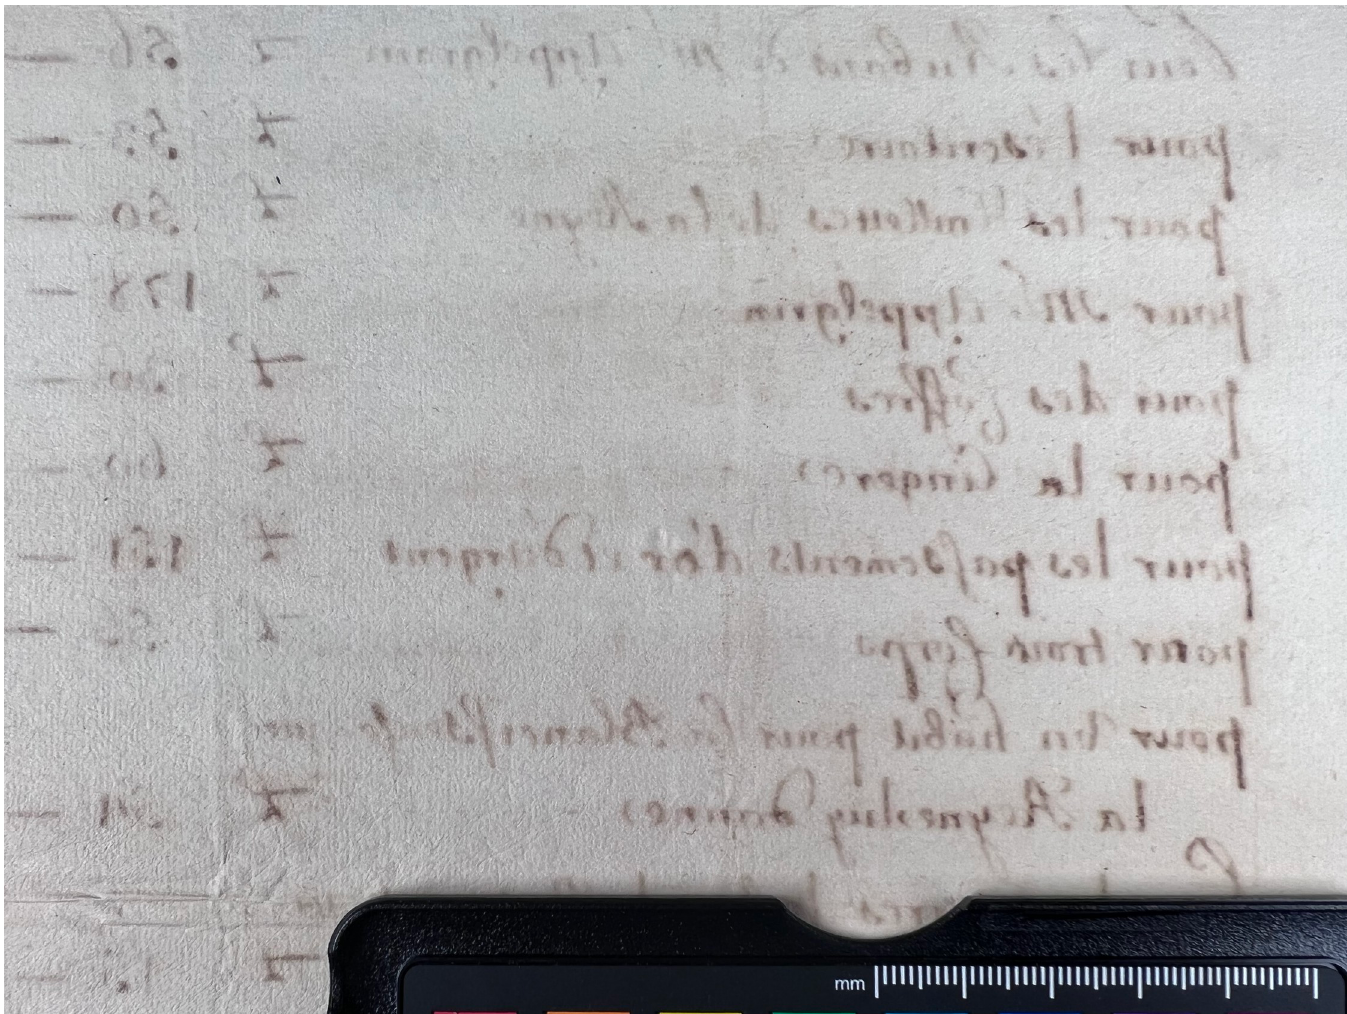
Fig 2. Burn through category 2. Example of document from the Azzolino collection displaying burn through 2 from verso.